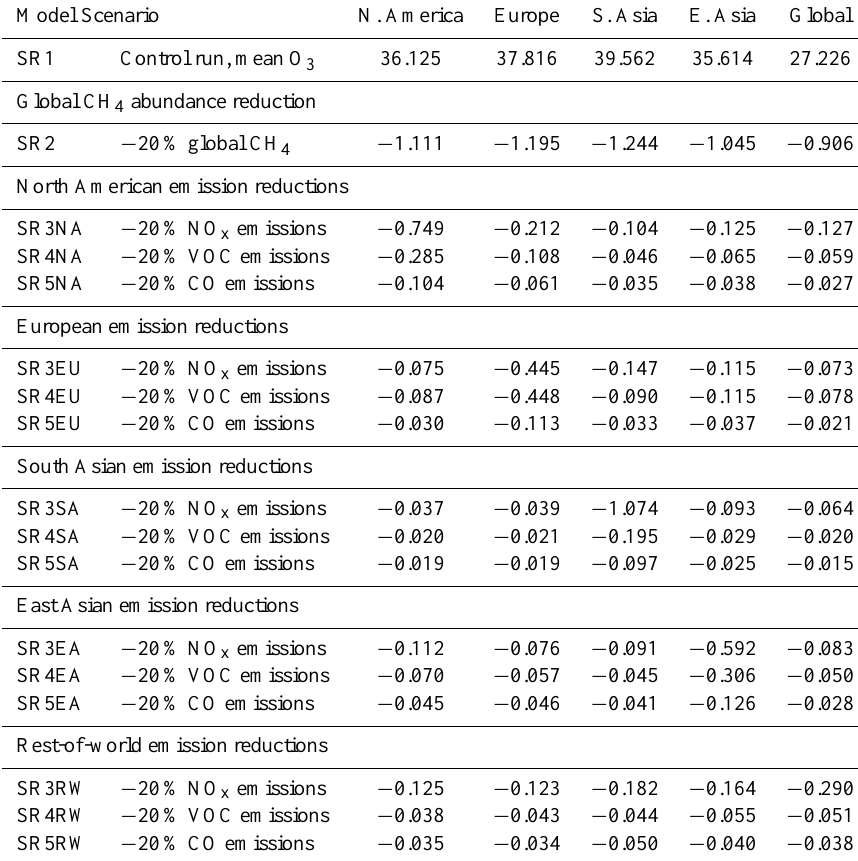
Table A1. Model ensemble mean annual surface O 3 changes (in ppb) used in the present analysis.